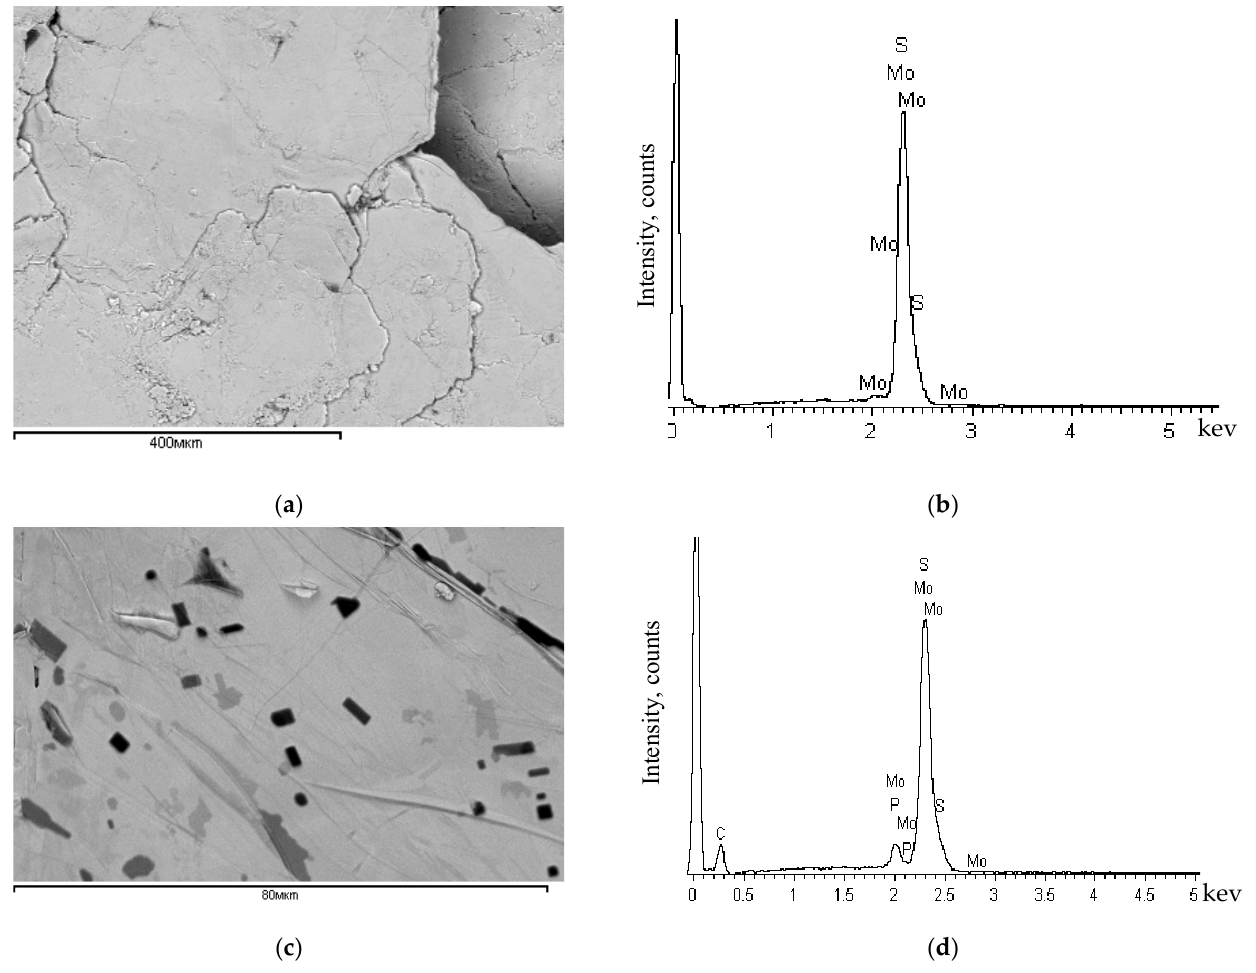
Figure 1. SEM image of molybdenite surface before ( a ) and after ( b ) contact with the reagent’s solutions and energy-dispersive spectrum of the surface areas before ( c ) and after ( d ) contact with the reagent’s